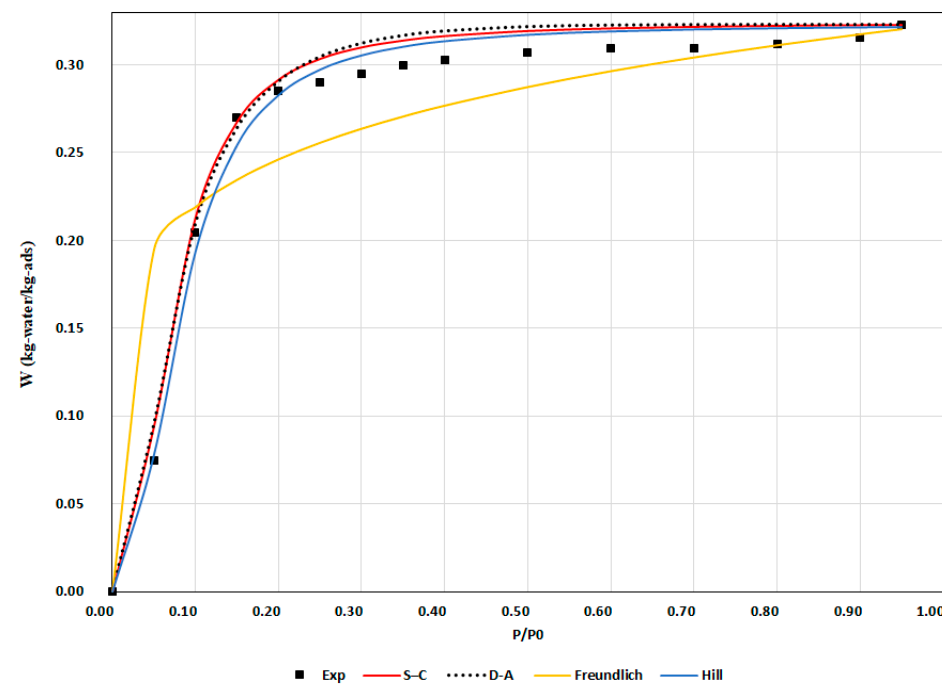
Figure 9. Water uptake comparison between experimental and isotherm model results at 34 °C.